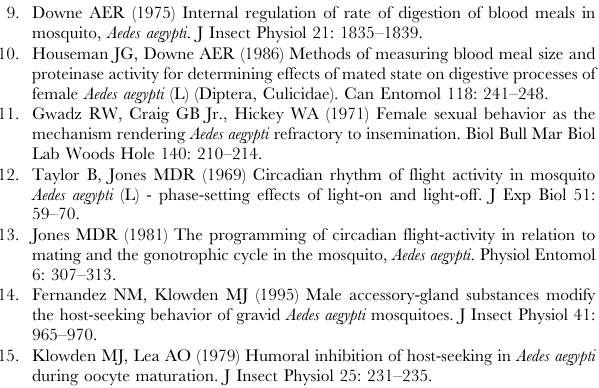
Table S6 Putative Aedes aegypti sperm proteins that were